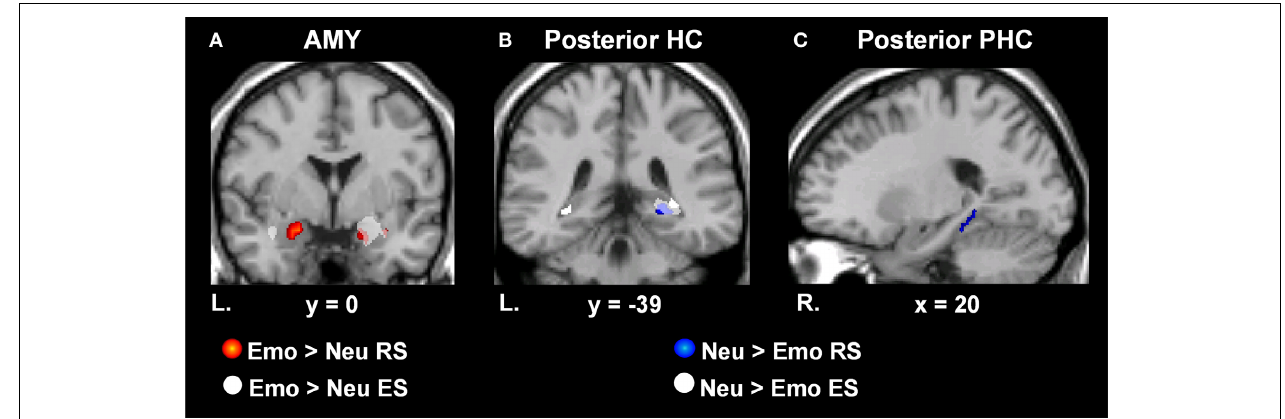
FIGURE 3 | Dissociating retrieval processes linked to the enhancement of emotional memory and increased engagement associated with neutral memory. MTL regions sensitive to Emo vs. Neu RS (red) and incidental ES (white) of Emo vs. Neu lure items presented during EM-1. Bilateral AMY activity was identified for Emo > Neu RS, but activity in the right hemisphere was accounted for by incidental Emo > Neu ES activity (A) . MTL regions showing greater RS activity for Neu > Emo items (blue) and incidental ES activity for Neu > Emo lure items (white) presented during EM-1. Right HC tail activity was identified for Neu > Emo RS, but was accounted for by encoding-related activity for lures during retrieval (B) . RS activity identified in the right posterior PHC, was unaccounted for by encoding related activity (C) . Areas indicated in red illustrate the difference in activation in response to Emo > Neu RS, masked with the main effect of